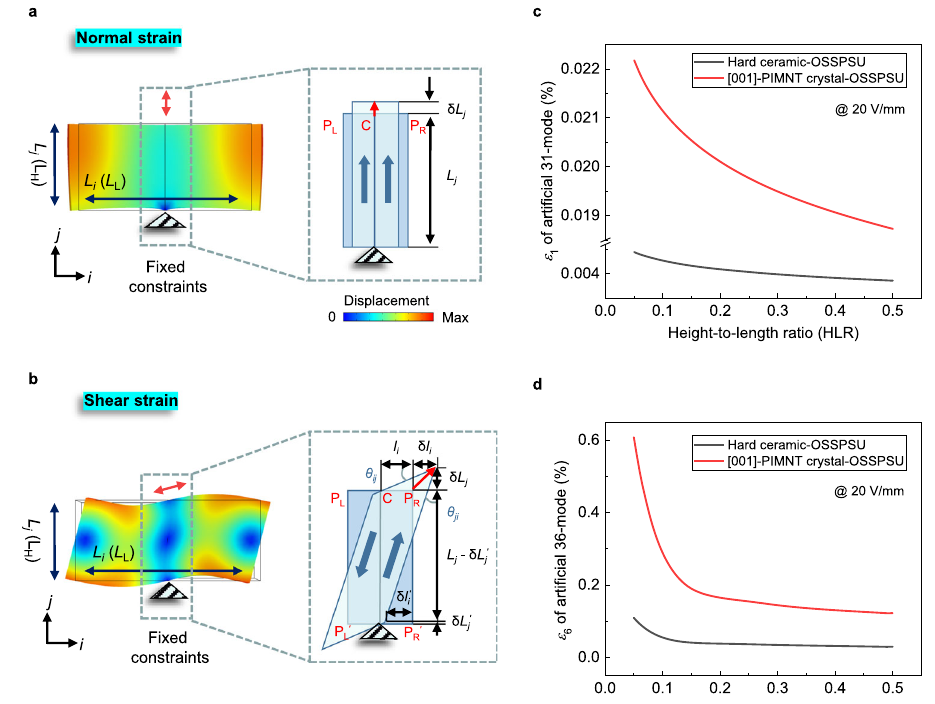
Fig. 3 | Strains of arti fi cial vibration modes with respect to geometric dimen- sion of two OSSPSU calculated by FEM simulation. a Geometrical diagram, boundary conditions, and deformations of the simulated normal strain ( ε λ : λ =1, 2, 3) by using OSSPSU; b shear strain ( ε λ : λ =4, 5, 6) by using OSSPSU. The black trianglesrepresentthe fi xedconstraint.Thereddouble-headedarrowsindicatethe displacement directions of motion points P L (point on the left of the selected